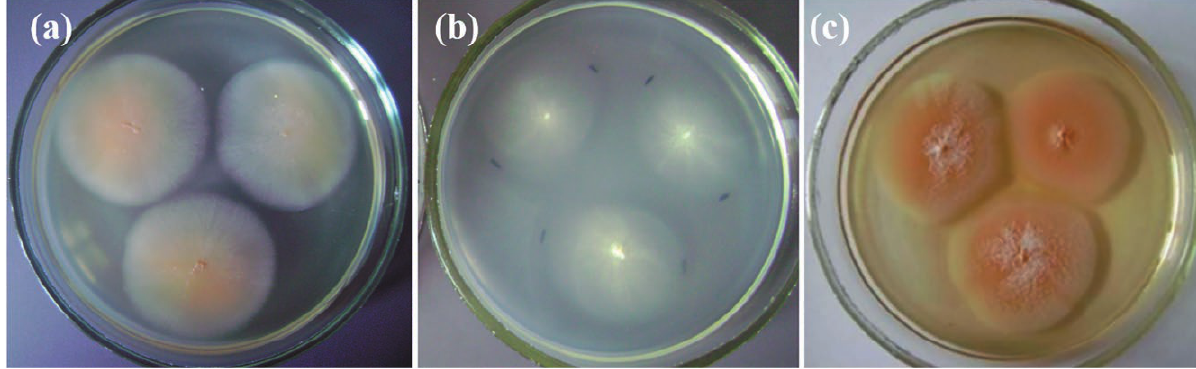
Figure 2. Colonies of Plectosphaerella melonis (isolate 502) on (a) PDA, (b) CZA, and (c)